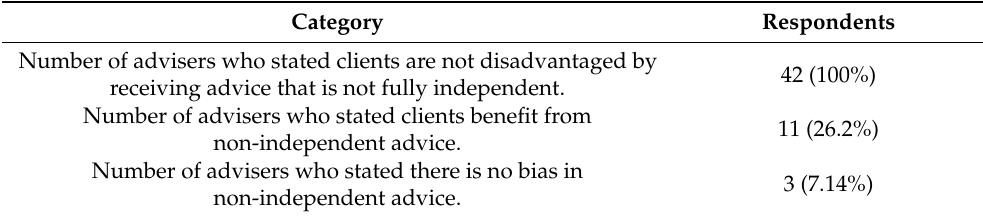
Table 4. Public impact. Category